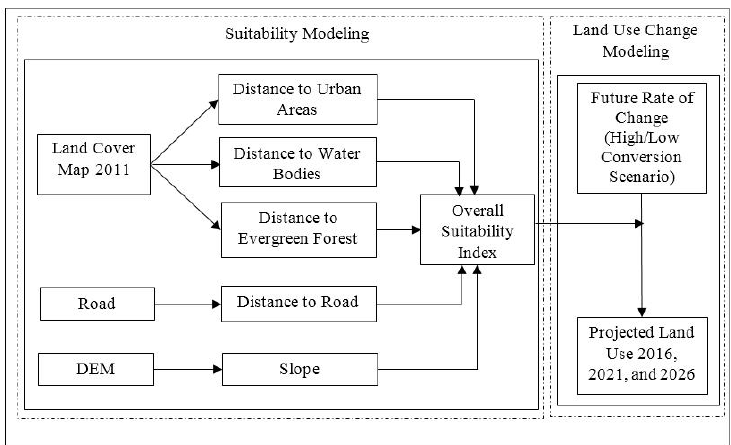
Figure 2. Framework for integrating suitability analysis with land use change modeling. The 2011 land cover map (30 × 30 m) is derived from National Land Cover Dataset available at USDA/NRCS (https://gdg.sc.egov.usda.gov/). Road layer is obtained from Natural Resources Spatial Analysis Lab at the University of Georgia. The digital elevation model (30 × 30 m) is derived from National Elevation Dataset available at